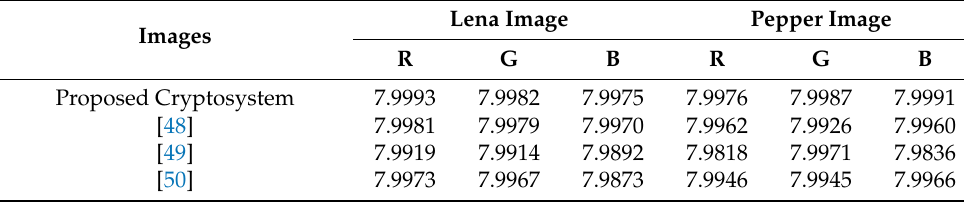
Table 7. Information Entropy.